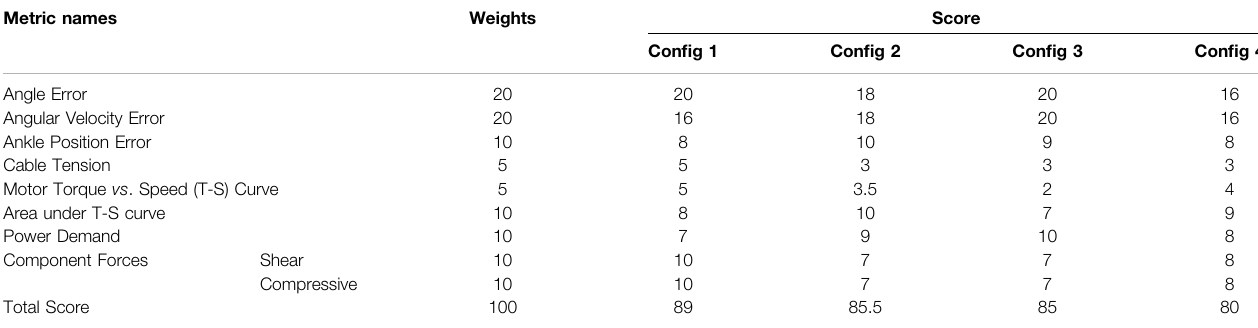
TABLE 3 | General metric table for decision